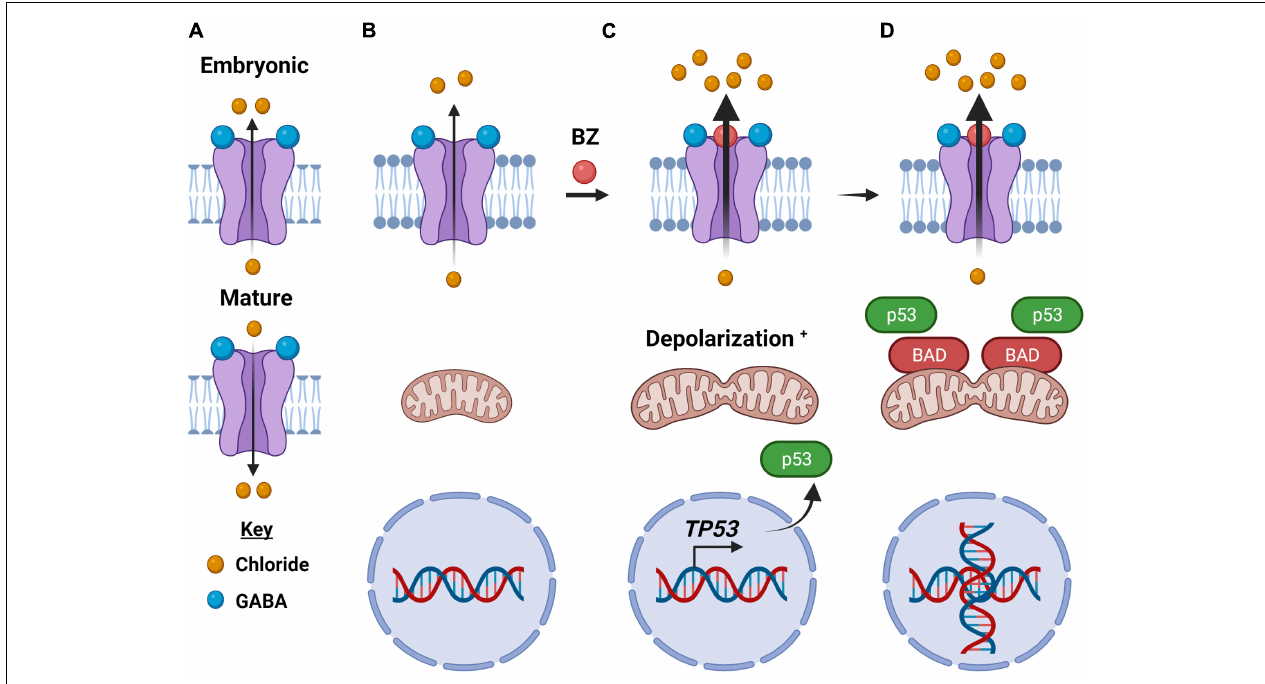
FIGURE 4 | How type-A GABA receptors may function as an electrochemical vulnerability to cancer cells. (A) In an embryonic cell, the GABA A receptor upon binding of GABA moves chloride anions out of the cell and is depolarizing (top), while in a mature neuron, GABA A receptors move chloride anions into the cell upon binding of GABA and is hyperpolarizing (bottom). (B) In cancer cells, the direction of ion flow is out of the cell, like that of the embryonic receptor. (C) Anion flow is enhanced upon binding of a benzodiazepine, a positive allosteric modulator of the GABA A receptor. Within minutes of benzodiazepine binding to the GABA A receptor, the significant efflux of chloride anions depolarizes the mitochondrial transmembrane as well causes their fission. In addition, there is enhanced expression of the oncogene TP53. (D) The intrinsic (mitochondrial) apoptotic pathway is activated, including an enhanced expression and localization of the BCL2 Associated Agonist of Cell Death (BAD) protein. There are also significant morphological changes in the cancer cells, including DNA duplication, as illustrated. Created with